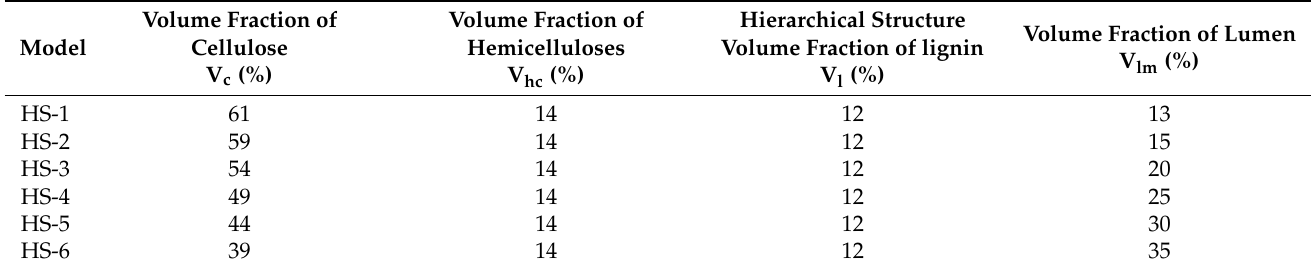
Table 2. Volume fraction of fiber constituents with different Hierarchical Structure.